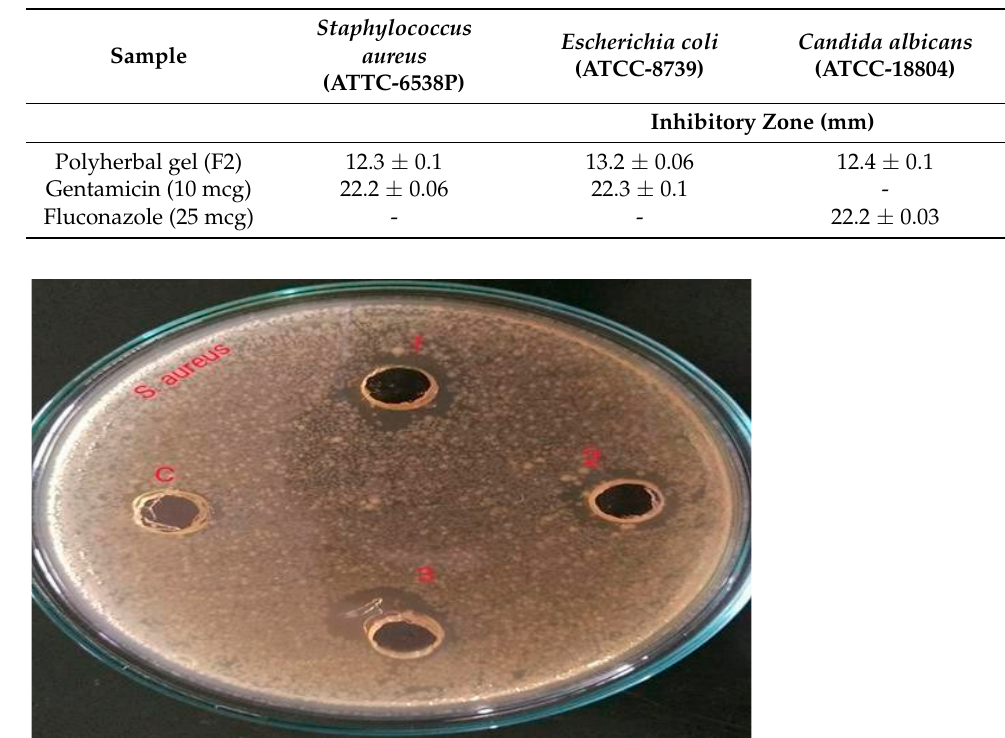
Table 3. Antimicrobial activity of the extract of Vigna radiata .